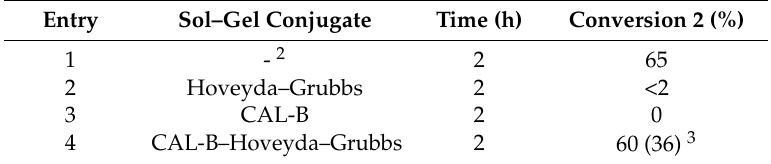
Table 4. Enzyme–Hoveyda–Grubbssecond-generationcatalystsol–gelconjugateinmetathesisreactionof 1 .